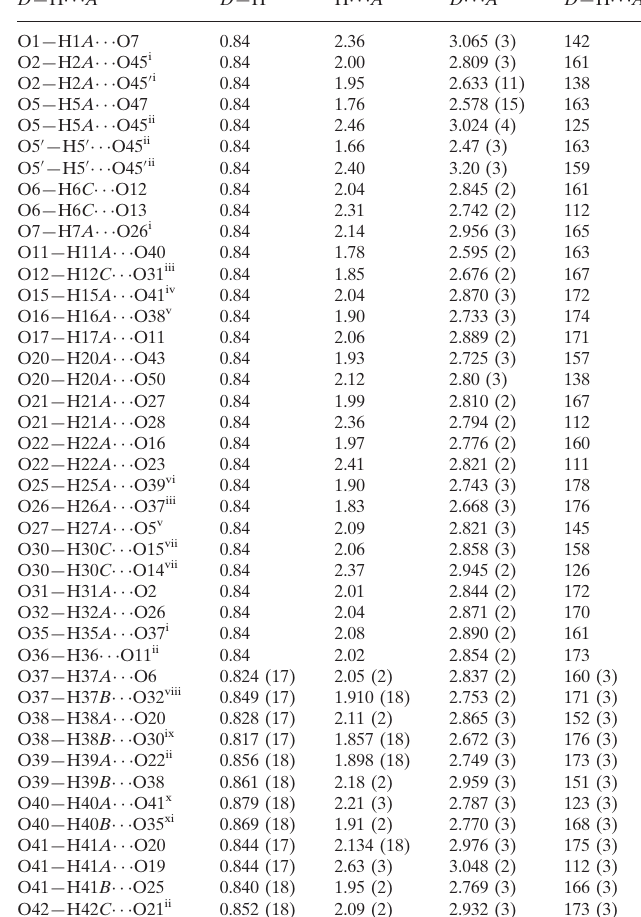
Hydrogen-bond geometry (A˚ , (cid:3)